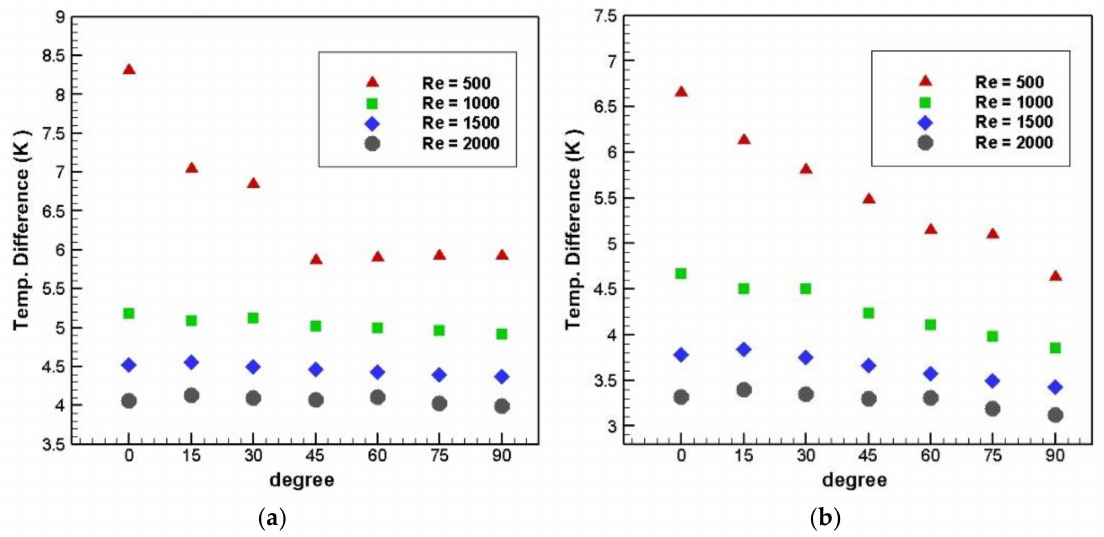
Figure 7. Temperature di ff erence in feed channel at ( a ) hot wall and ( b ) cold wall. Generally, increasing the Reynolds number means that potent fluid is flowing through the